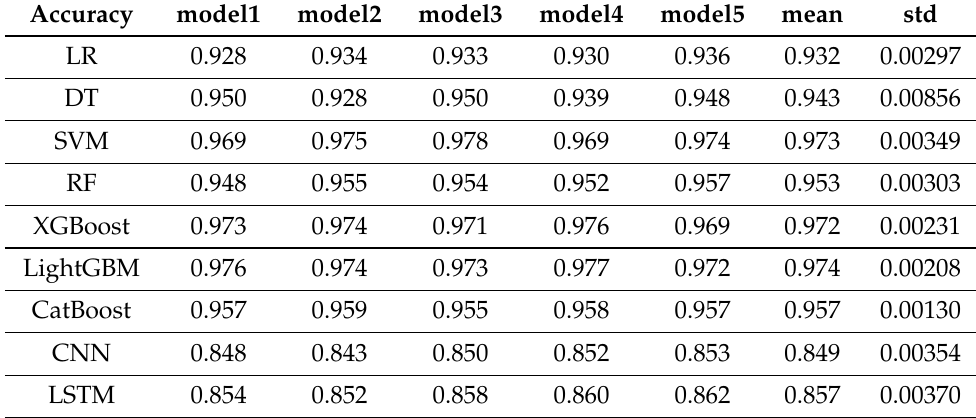
Table 10. Validation accuracy of five-fold cross-validation on Dataset6.